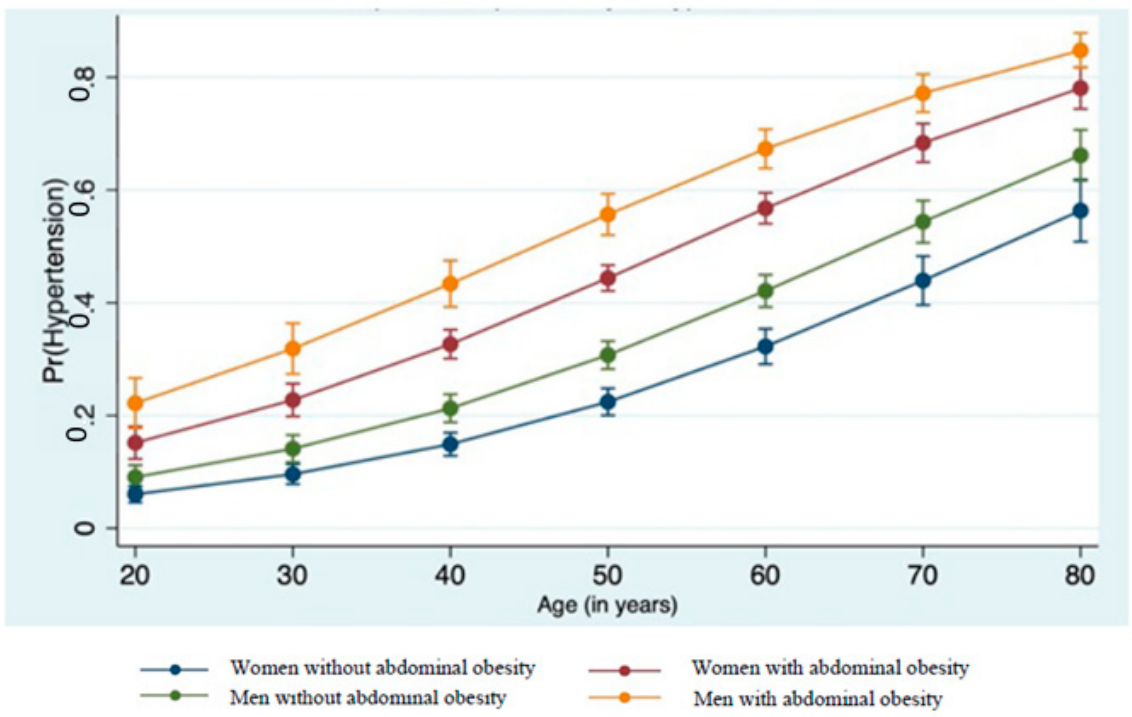
Figure 3. The predicted probability of hypertension, by abdominal obesity, among men and women.